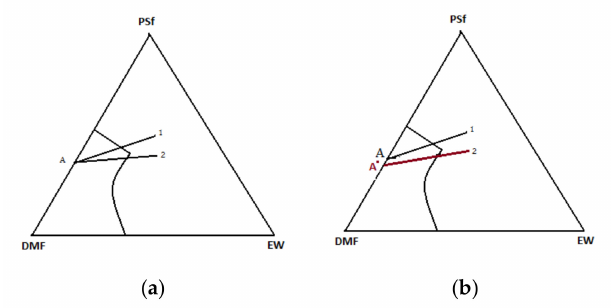
Figure 9. The schematic composition route for the active layer (1) and the porous layer (2) of the polymeric film starting from the initial composition A: according to the theory—( a ) and according to this work—( b